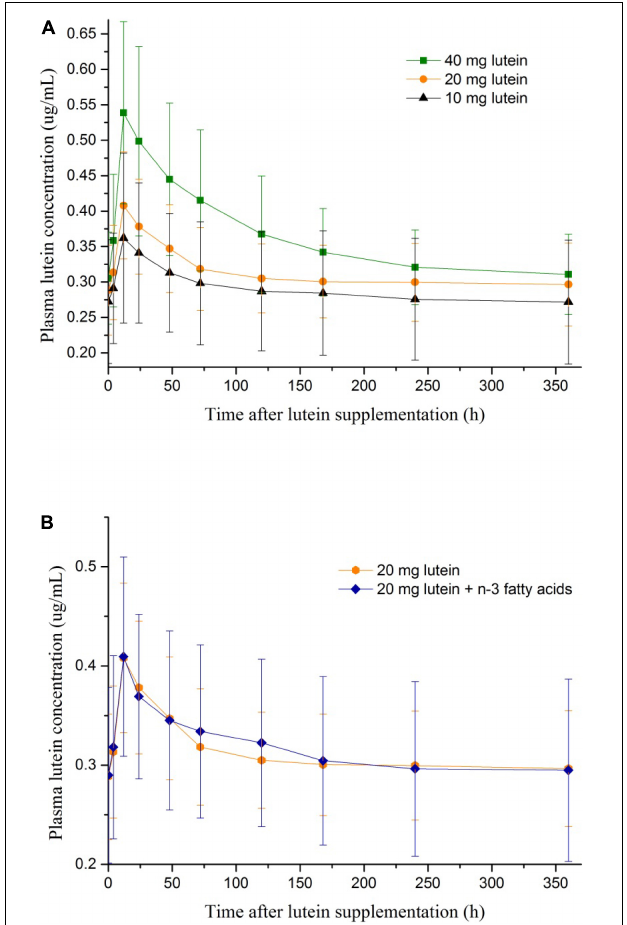
FIGURE 1 | (A) The change of plasma lutein concentrations after lutein supplementations of different dosages. (B) The change of plasma lutein concentrations after lutein supplementations with and without n-3 polyunsaturated fatty acids.